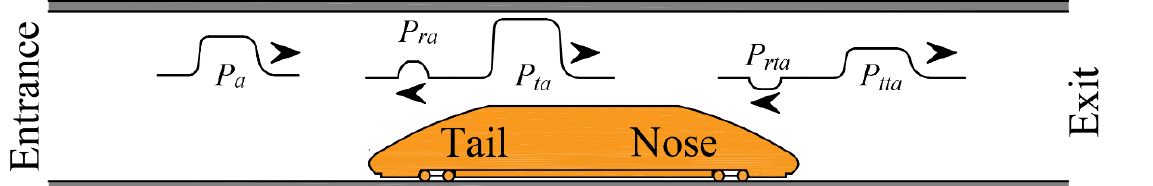
Figure 15. Schematic of propagation and reflection of a pressure wave between tunnel wall and train body surface in Stage II. (Note: P a : pressure wave, P ra : reflected wave of P a , P ta : transmitted wave of P a , P rta : reflected wave of P ta , P tta : transmitted wave of P ta ).